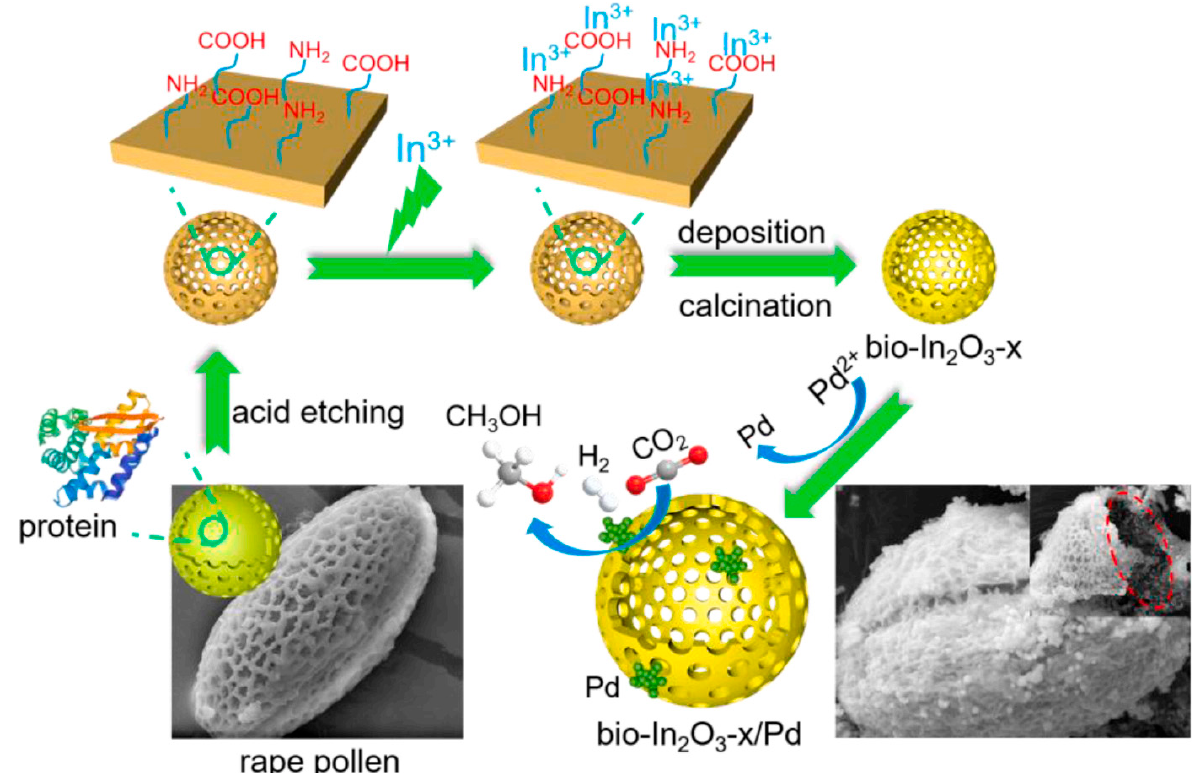
Figure 6. Fabrication routes of supported bio-In 2 O 3-x /Pd catalysts. Reproduced with permission from ref. [89]. Copyright 2021 Elsevier.